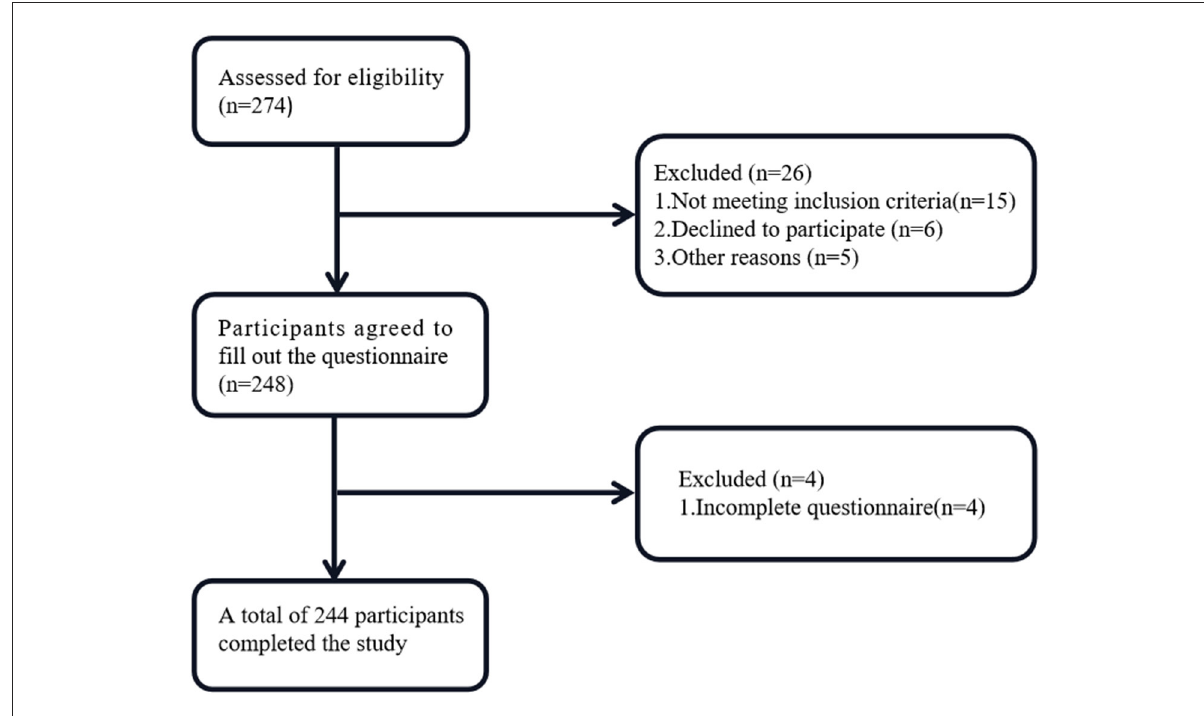
FIGURE1 Flowchart on participant